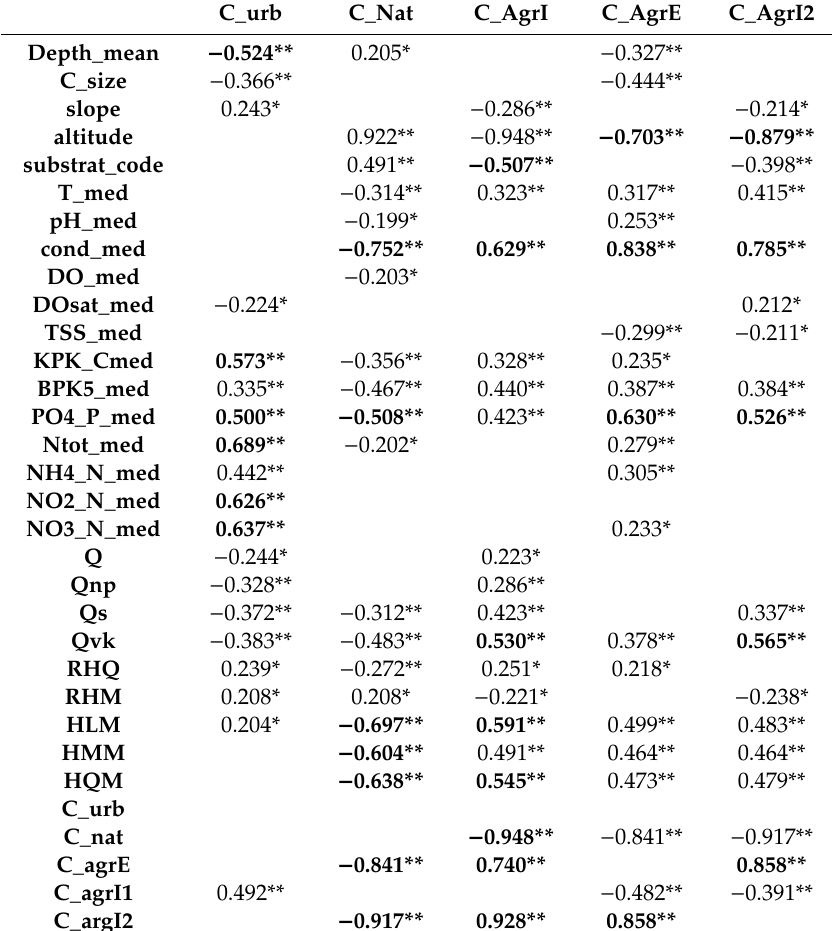
Table A5. Statistically significant Spearman’s correlation coe ffi cients (RSp) for the combinations of land use variables with variables from all groups (** P < 0.01, * P < 0.05); | RSp | > 0.50 are in bold. See Table 2 for environmental variable codes.